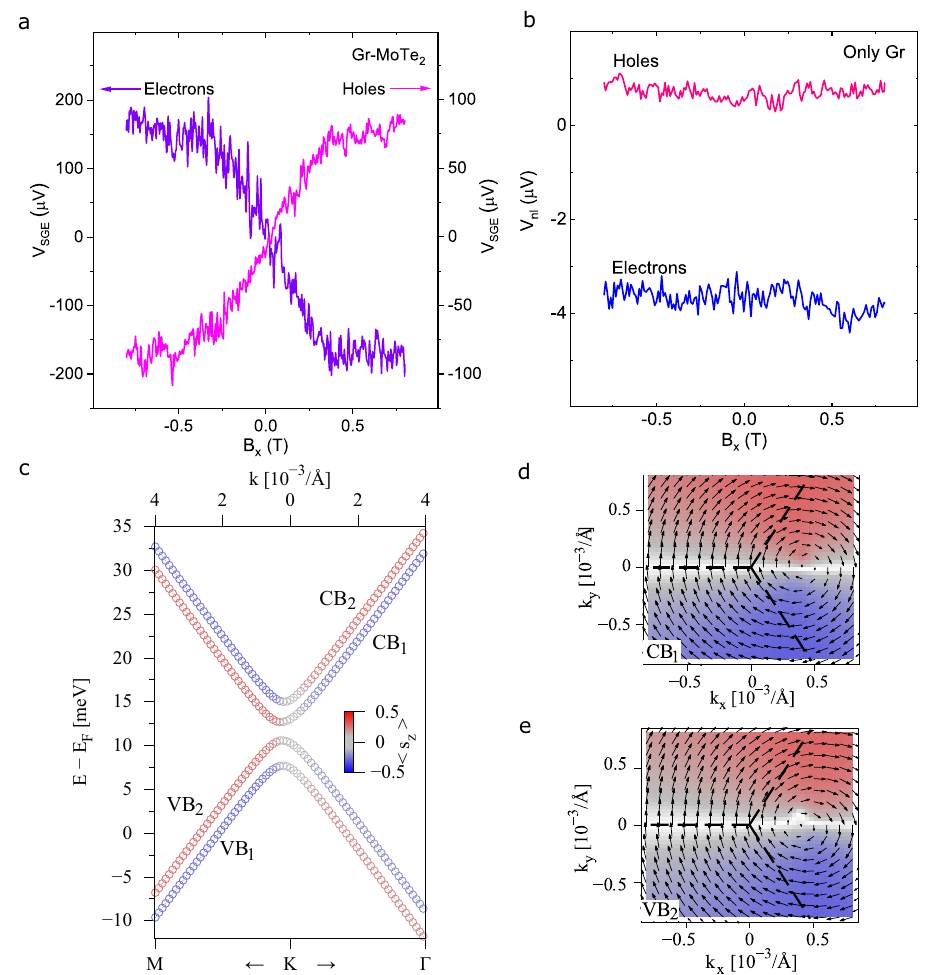
Fig. 3 Gate-controlled switching of spin-galvanic signal in graphene-MoTe 2 heterostructure at room temperature. a Measured spin-galvanic signal ( V SGE ) by sweeping a magnetic fi eld along the x -axis ( B x ) at room temperature in graphene-MoTe 2 heterostructure (Dev 1) with I = 80 µ A and applied gate voltages of V g = 20 V and − 10V to position the Fermi level ( E f ) in the electron and hole doping regimes, respectively. A linear background is subtracted from the data (see Supplementary Fig. S9). b Measured non-local signals ( V nl ) in pristine graphene Hall cross by sweeping a magnetic fi eld in the x - direction ( B x ) for electron- and hole-doped regions with I = 100 µ A, V g = 70 V and − 50 V, respectively. c The low energy band structure of graphene in proximitized to MoTe 2 from density functional theory calculations. The color is the expected value of the spins polarized along with the z-direction (s z ). d, e Density functional theory calculations for similar clockwise spin texture in the outermost conduction ( ϵ CB